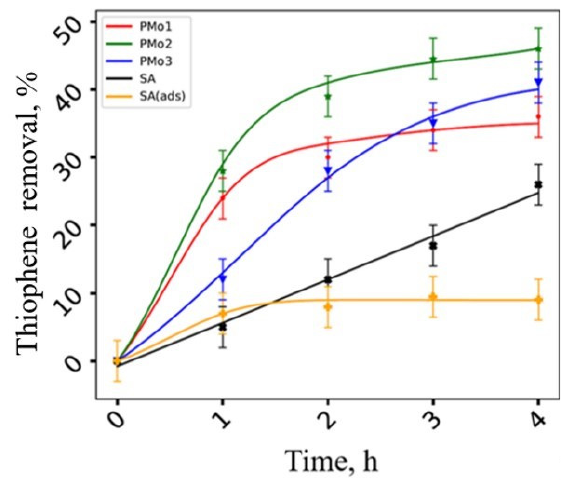
Figure 7. Thiophene removal versus time.